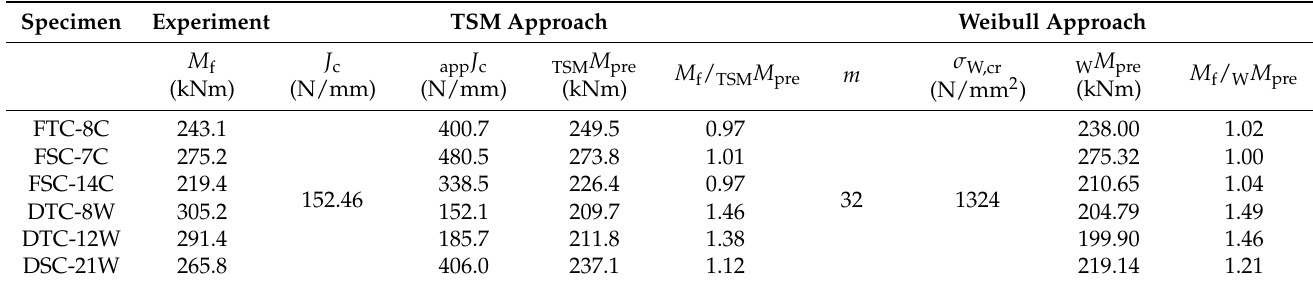
summarized in Table 5, where TSM M pre and W M pre represent the predicted bending mo- ments of failure calculated using the TSM approach and the Weibull approach, respectively. Table 5. Failure moment prediction